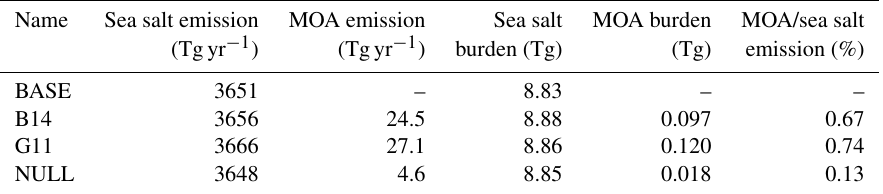
Table 5. Annual global mean emissions and burdens of MOA and sea